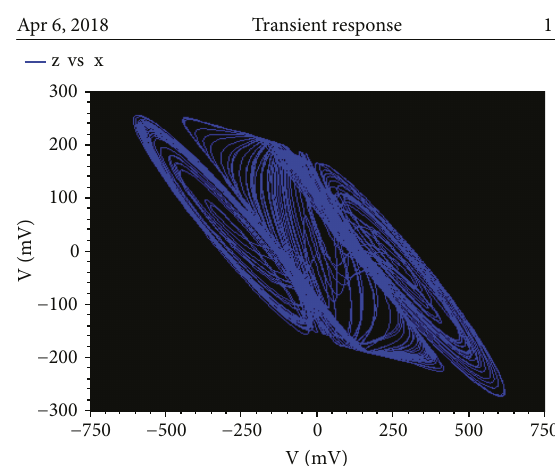
Figure 15: The phase portrait in the x - z plane (S and S are turned o ff 3